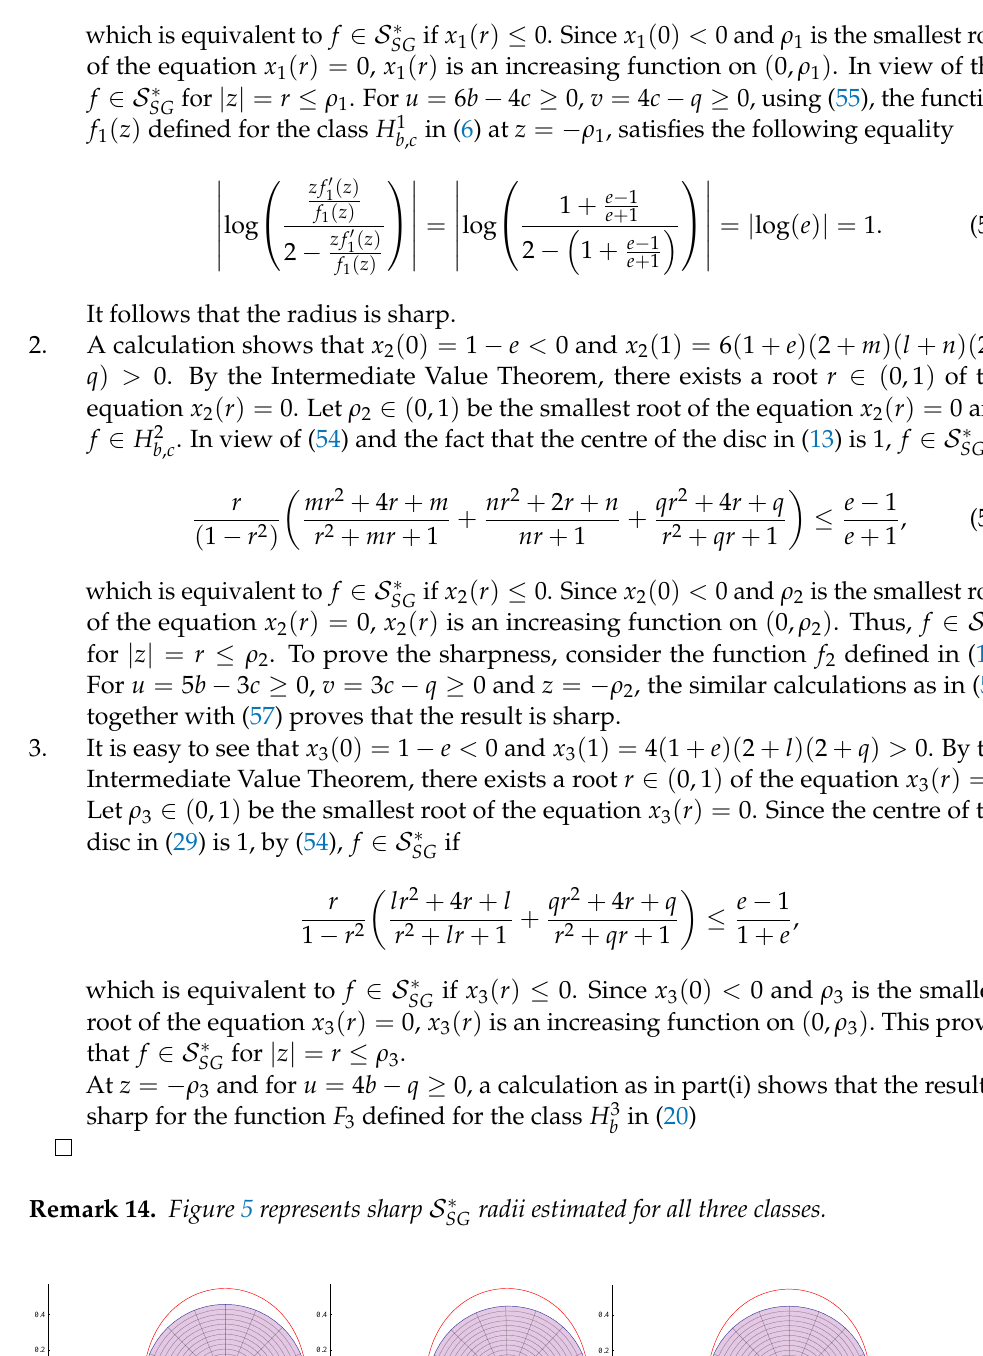
Figure 5. Sharp S ∗